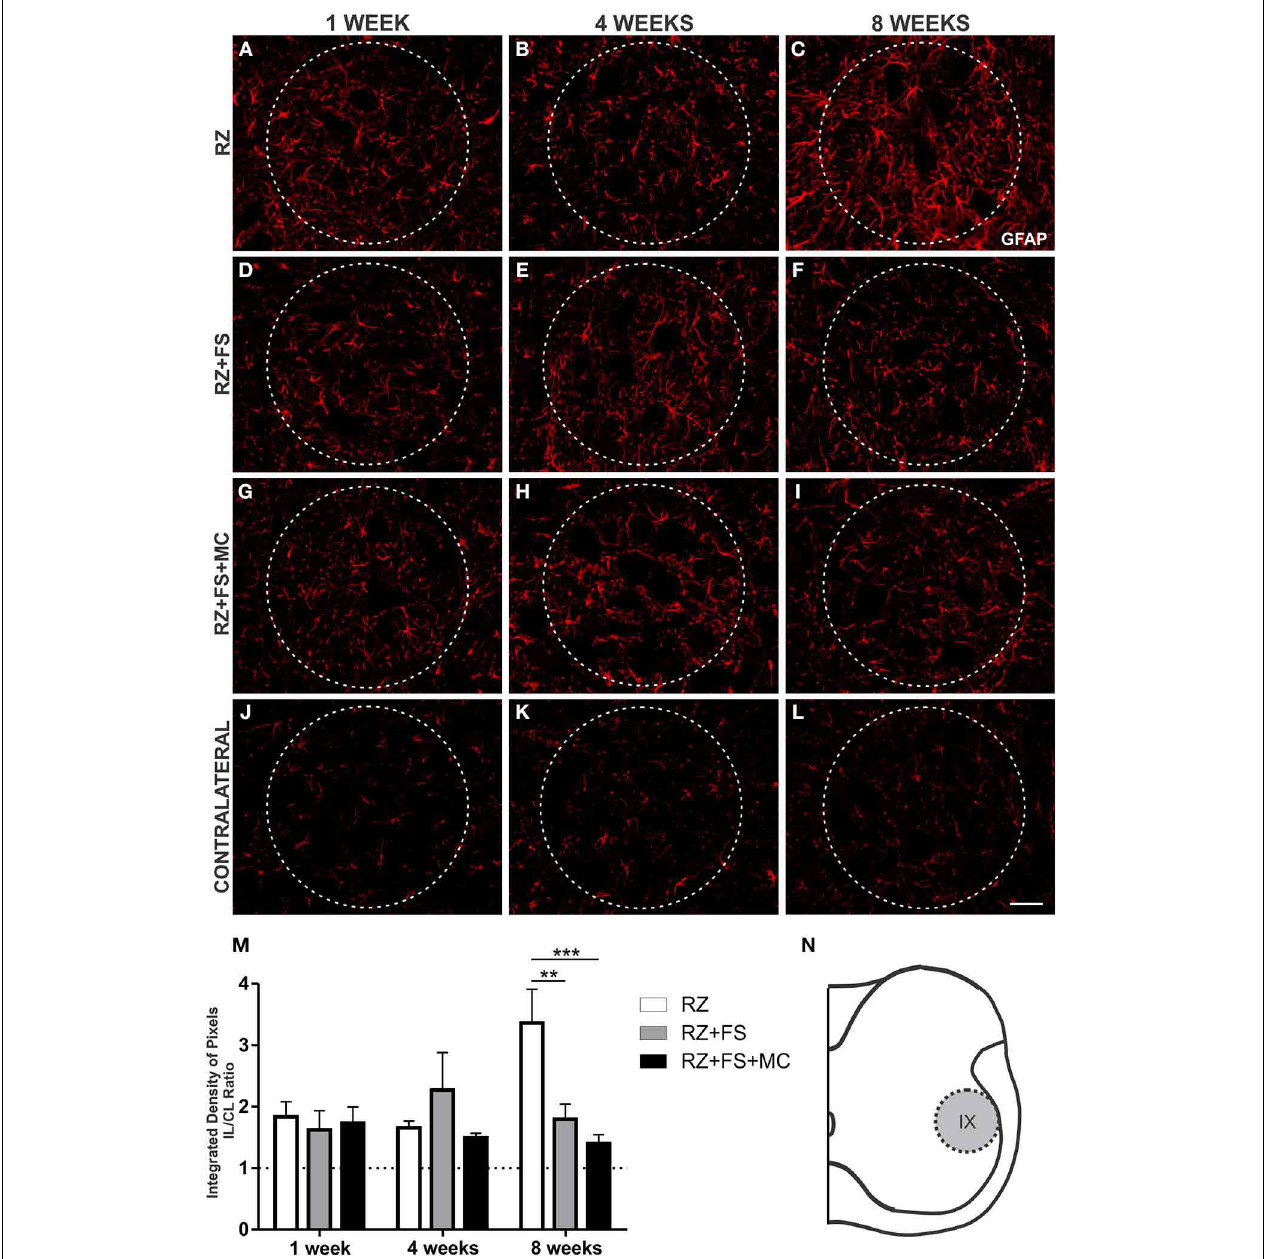
FIGURE 5 | Immunohistochemistry for glial fibrillary acidic protein (GFAP). (A–L) Representative images of RZ, RZ + FS and RZ + FS + MC, 1, 4, and 8 weeks post lesion. (M) Quantification (ratio IL/CL) of the integrated density of pixels, obtained in the region delimited by dashed